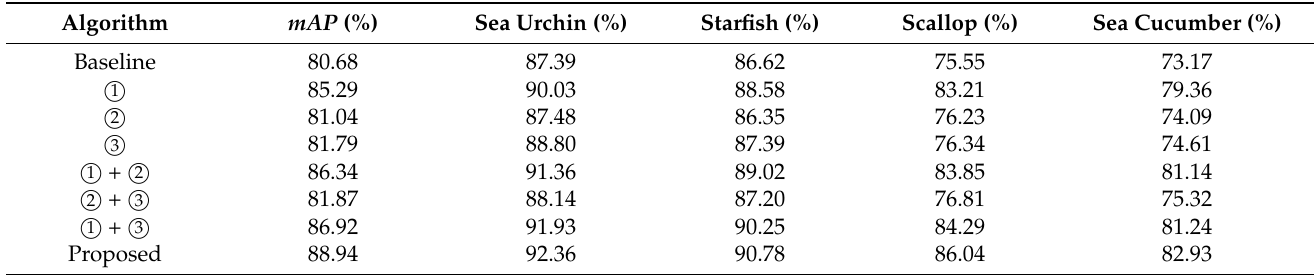
Table 1. Test results of URPC2018